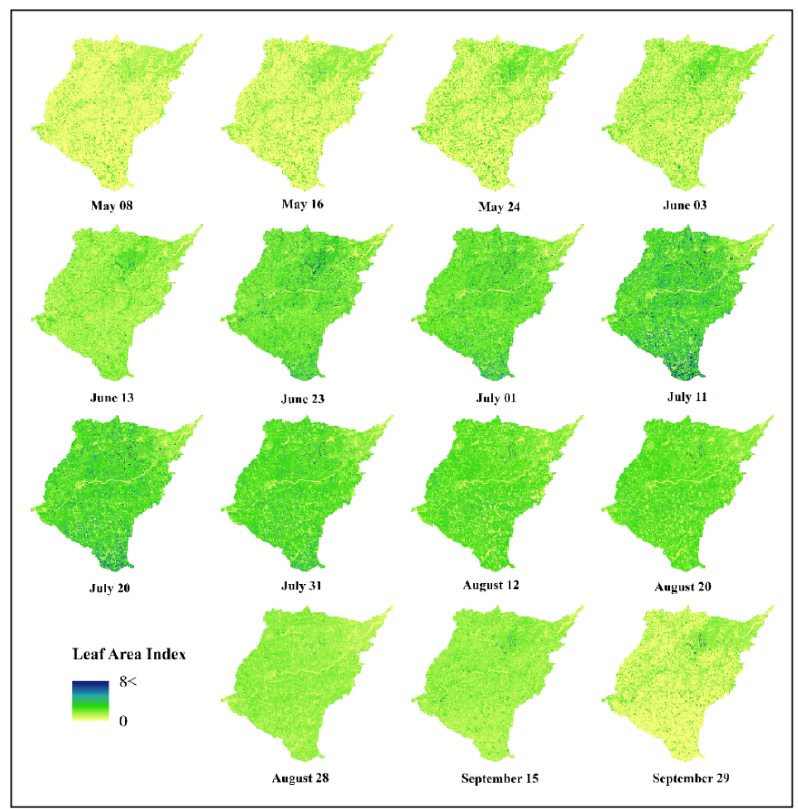
Figure 5. Estimated leaf area index (LAI) time series in 2018 over the watershed based on empirical equations.